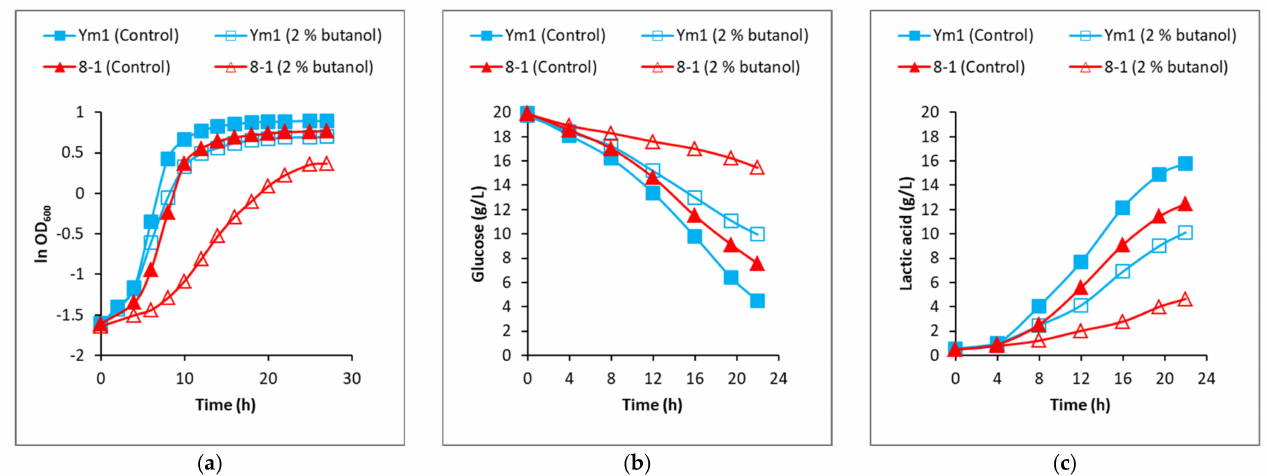
Figure 2. Growth kinetics of L. plantarum strains Ym1 and 8-1 exposed to butanol stress. ( a ) Biomass formation of L. plantarum Ym1 and L. plantarum 8-1 in control MRS medium and MRS supplemented with 2% ( v / v ) butanol. Natural logarithm (ln) of the average optical density of the cultures from three different experiments is presented. ( b ) Time profile of glucose consumption. ( c ) Time profile of lactic acid